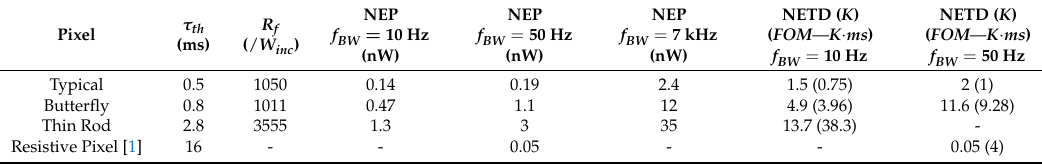
Table 5. Comparison between our pixels and a classical resistive bolometer for three integration bandwidths—all electromechanical devices are set at their onset of nonlinearity.